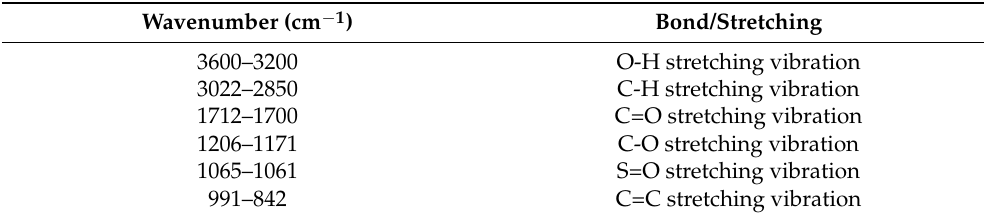
Table 5. FTIR spectra of key functional groups and their correspondence wavenumber (cm − 1 ) of free lipase, DES5, and